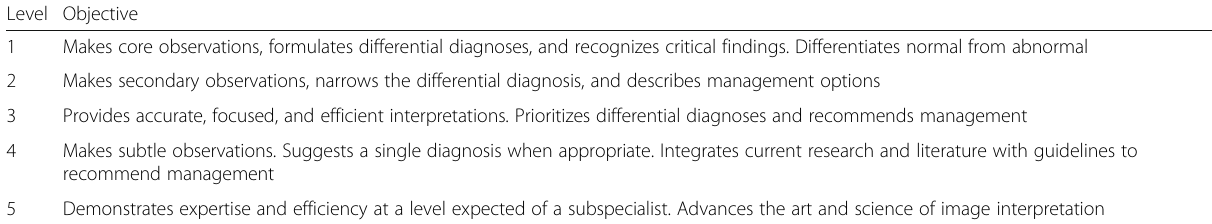
Table 6 Milestone MK2: interpretation of examinations [7] Level